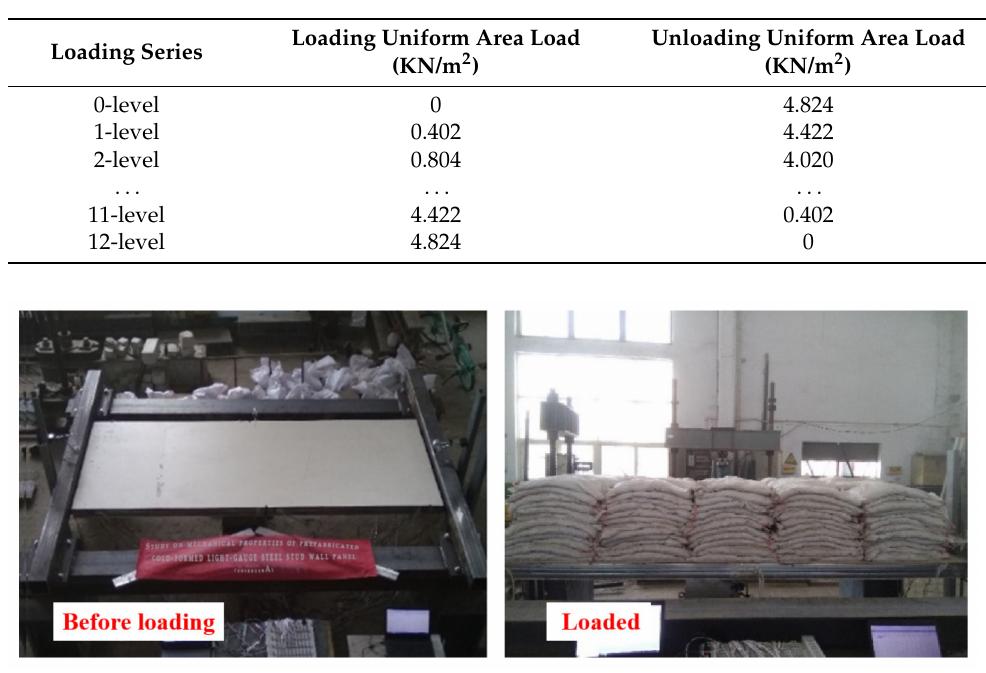
Table 3. Loading system of the heap load test.